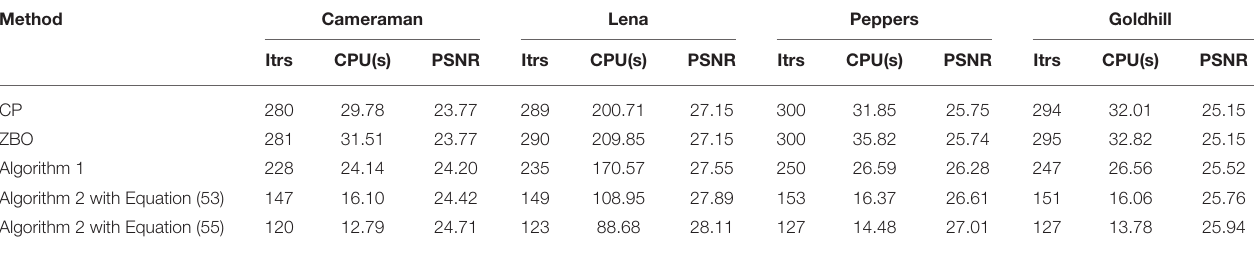
TABLE 4 | Numerical results for the L1-TV model for images blurred by the (15 , 10)-GBM.